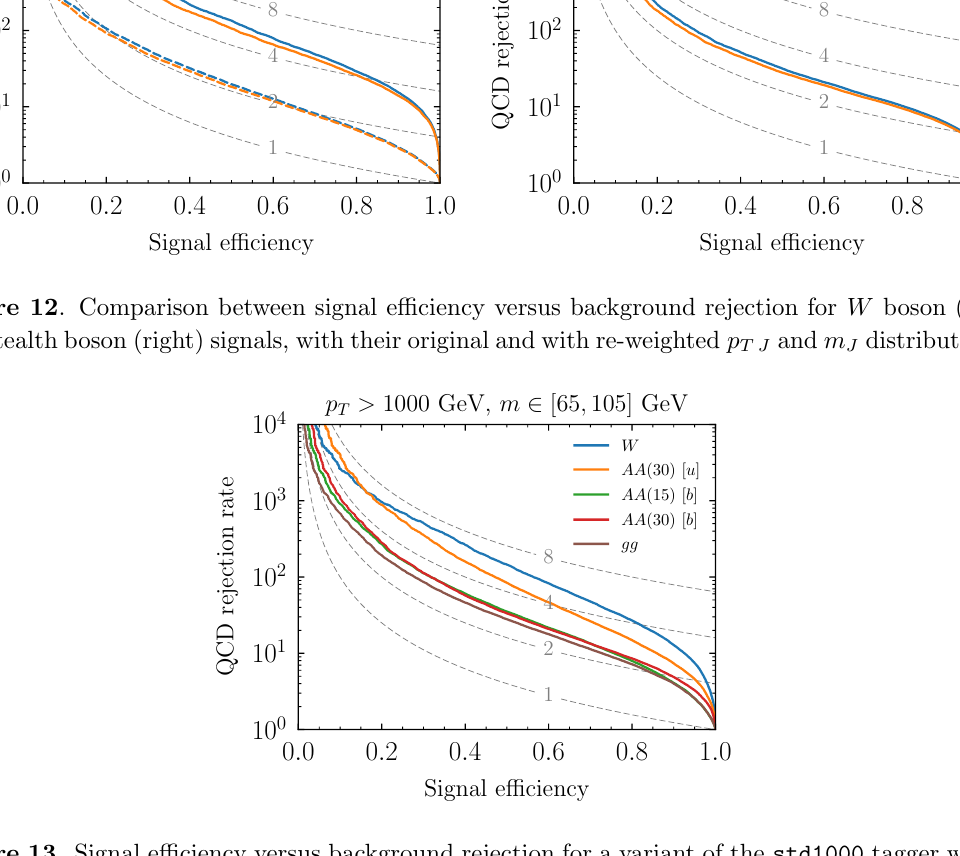
Figure 13 . Signal e(cid:14)ciency versus background rejection for a variant of the std1000 tagger which does not use (cid:28) (2) . The performance is identical to that of the std1000 tagger in (cid:12)gure 1. 1 p T J and m J range) can be compared to those in (cid:12)gure 1 (right), to see that they are